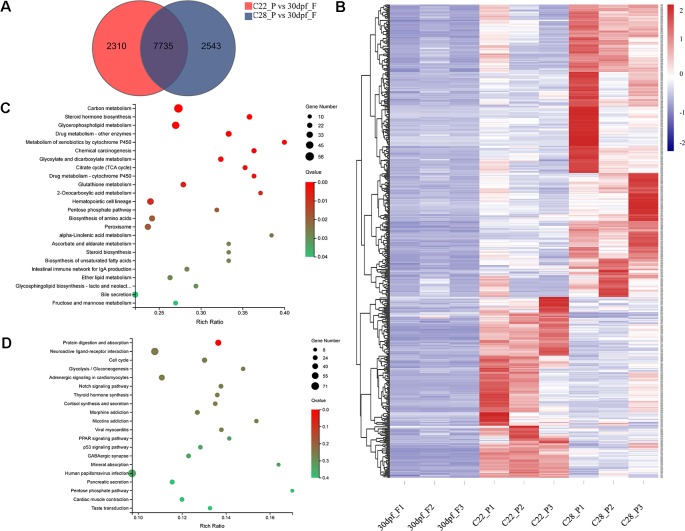
Gene expression patterns in pseudomale formed under high temperature and normal temperature. (A) Number of DEGs shown by Venn diagram. (B) Heatmaps showing the expression of DEGs found both in C22_P vs 30dpf_F and C28_P vs 30dpf_F (red: higher expression, blue: lower expression). (C) Enriched KEGG pathways of DEGs up-regulated in C28_P compared to C22_P (q < 0.05). (D) Enriched KEGG pathways of DEGs down-regulated in C28_P compared to C22_P (q < 0.05), graph showing top 20 significant terms.